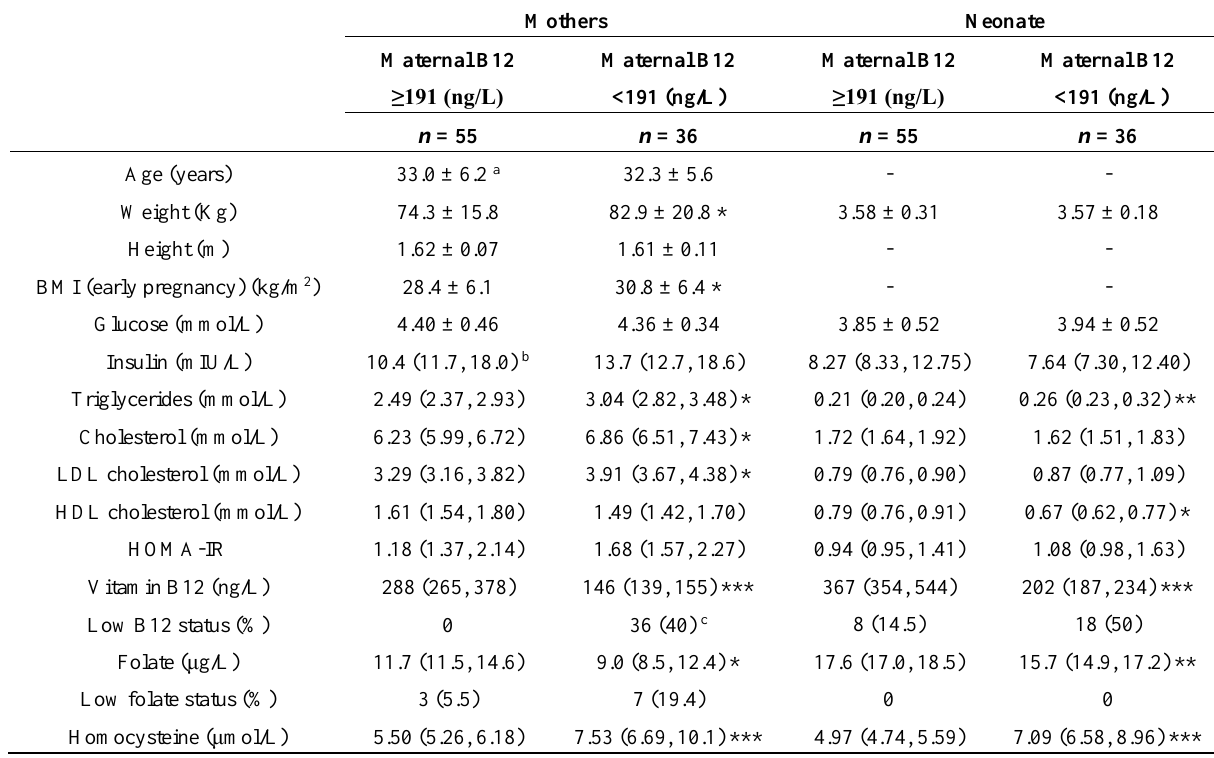
Table 2. Clinical characteristics of mothers and neonate according to maternal B12